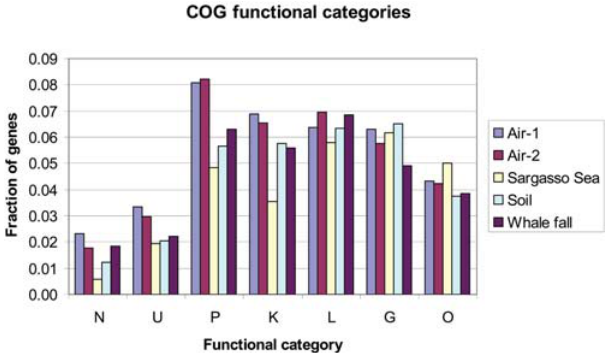
Figure 3. COG analysis. Predicted ORFs from the two air samples in this study and the other 3 environmental samples from previous studies were mapped to orthologous groups and broad functional categories according to the COG and STRING databases. Only functions that are more common in air than in other environments are depicted: N, Cell motility and secretion; U, Intracellular trafficking and vesicular transport; P, Inorganic ion transport and metabolism; K, Transcription; L, DNA replication, recombination and repair; G, Carbohydrate transport and metabolism; and O, Posttranslational modification.